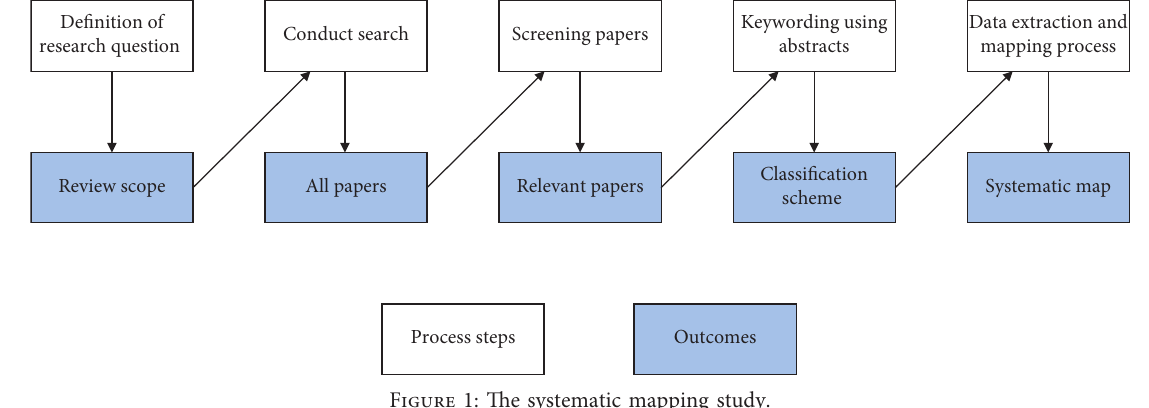
Figure 1: The systematic mapping study.